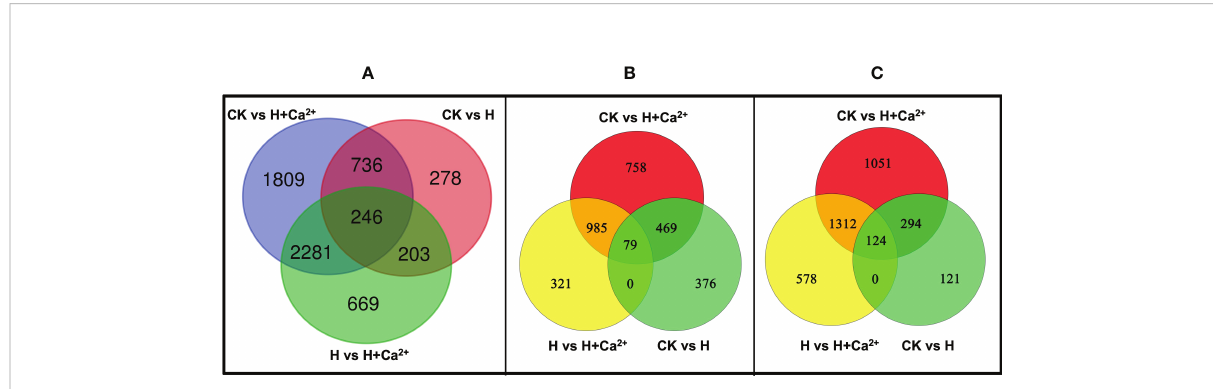
FIGURE 1 Venn diagram of the differentially expressed genes (DEGs) in pairwise analysis. (A) total DEGs, (B) upregulated DEGs, (C) downregulated DEGs.